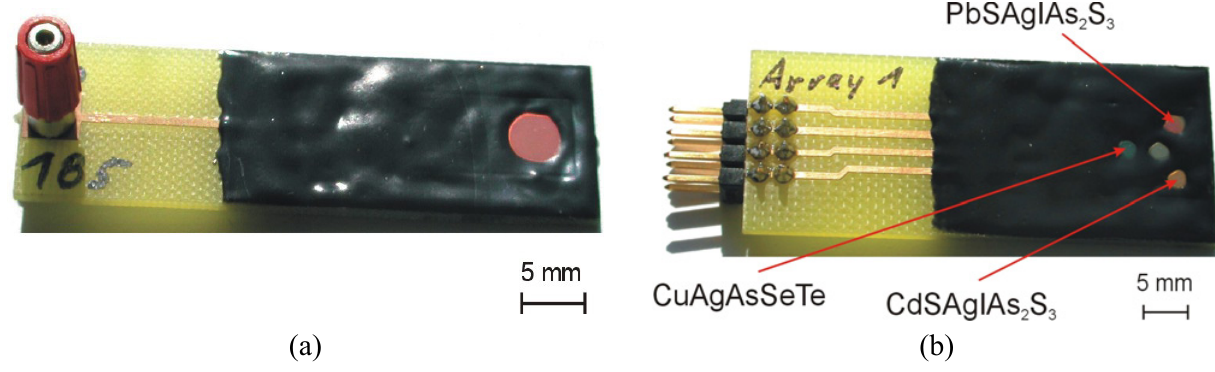
Figure 2. (a) Video-microscopic picture of a lead thin-film single microsensor (PbSAgIAs of the thin-film sensor array with three different chalcogenide glass thin